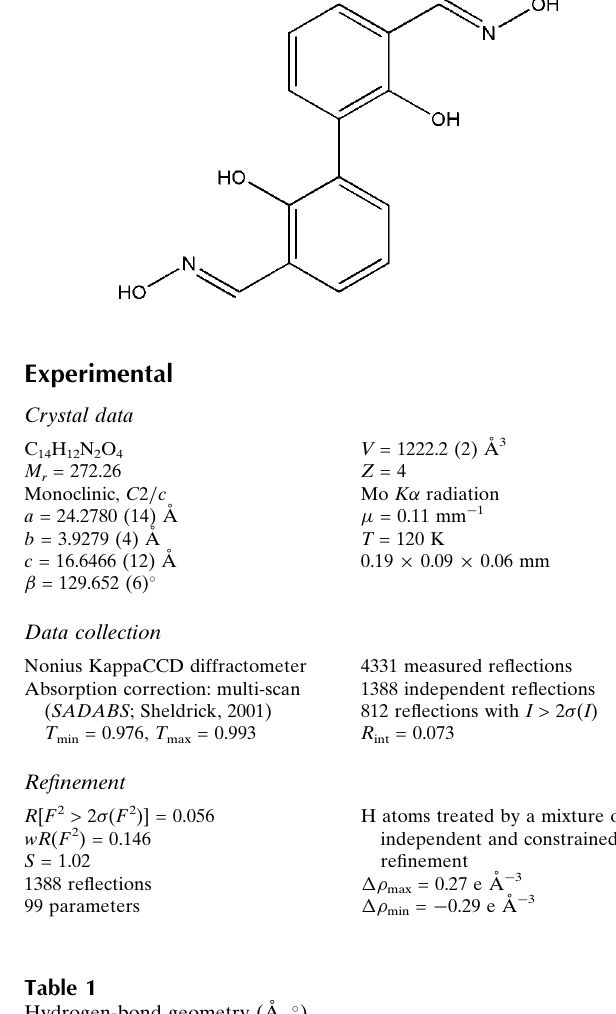
Hydrogen-bond geometry (A˚ , (cid:2)